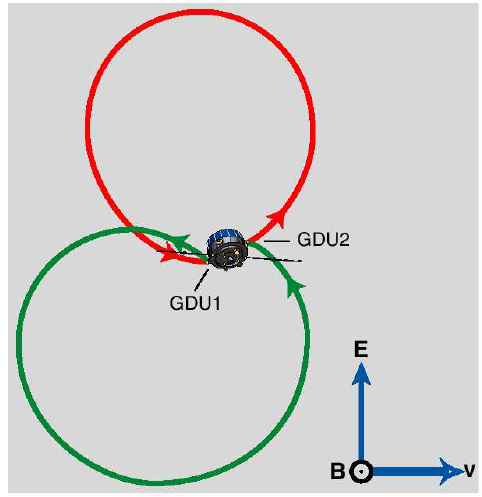
Fig. 2. The operational principle of the EDI electron drift instru- ment on Cluster, using two gun-detector units (GDU1 and GDU2) emitting two beams of keV electrons and detecting their drift upon return. For any given magnetic field B and drift velocity v , here assumed to be solely due to an electric field E , only one orbit exists that connects each gun with the opposite detector, enabling a unique determination of v and hence of E . The drawing is not to scale: in a 100-nT magnetic field, the orbits of the EDI electrons reach 2km from the spacecraft. For details, see Paschmann et al. (2001).